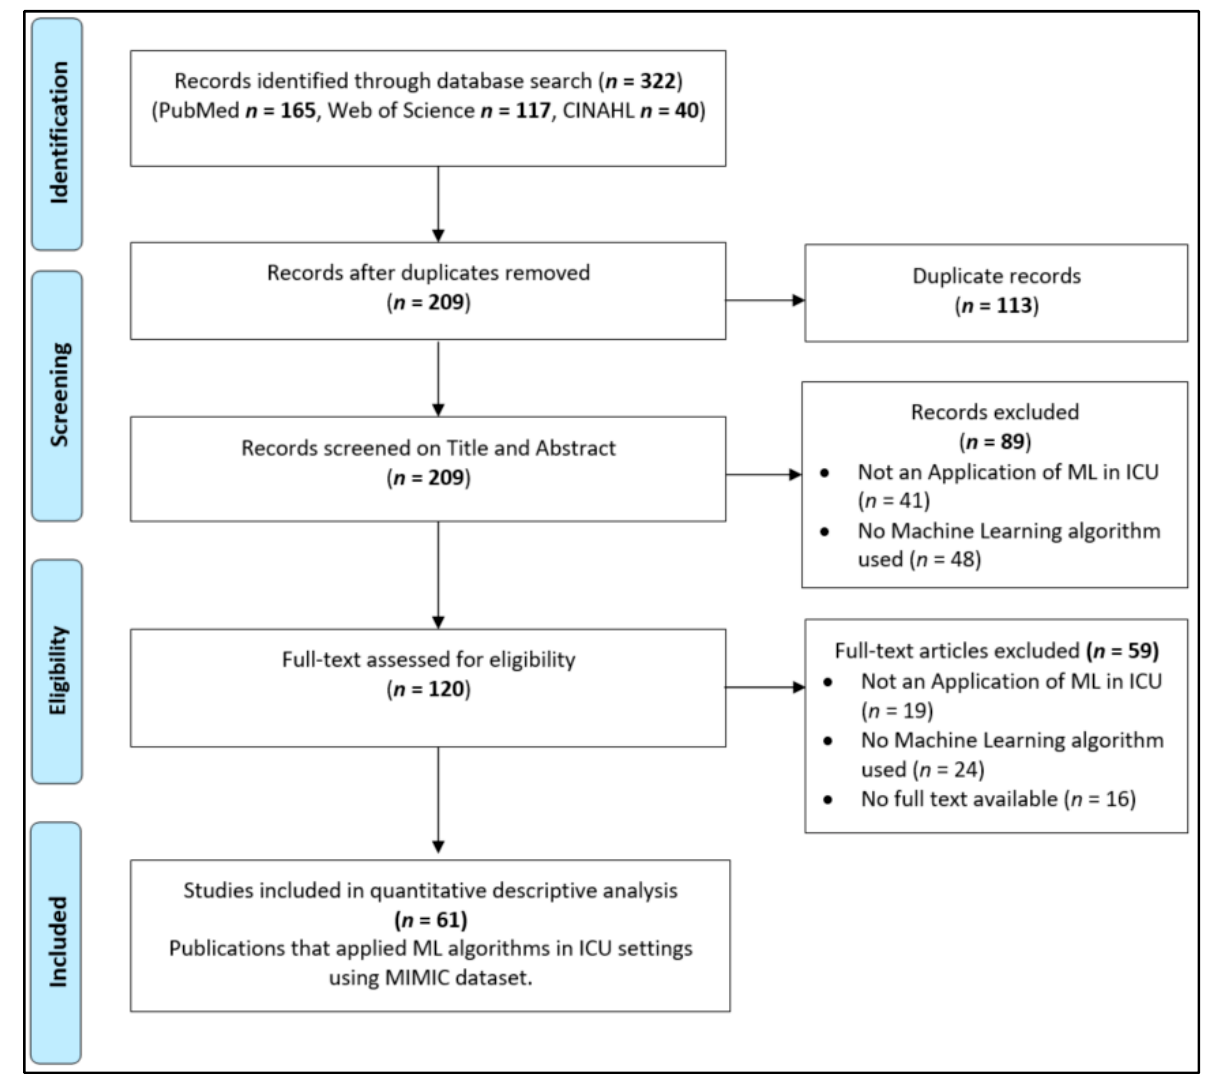
Figure 1. Preferred Reporting Items for Systematic Reviews and Meta-Analyses (PRISMA) flow diagram of systematic identification, screening, eligibility, and inclusion of publications that applied Machine Learning (ML) techniques in Intensive Care Unit (ICU) settings using Medical Information Mart for Intensive Care (MIMIC) dataset.